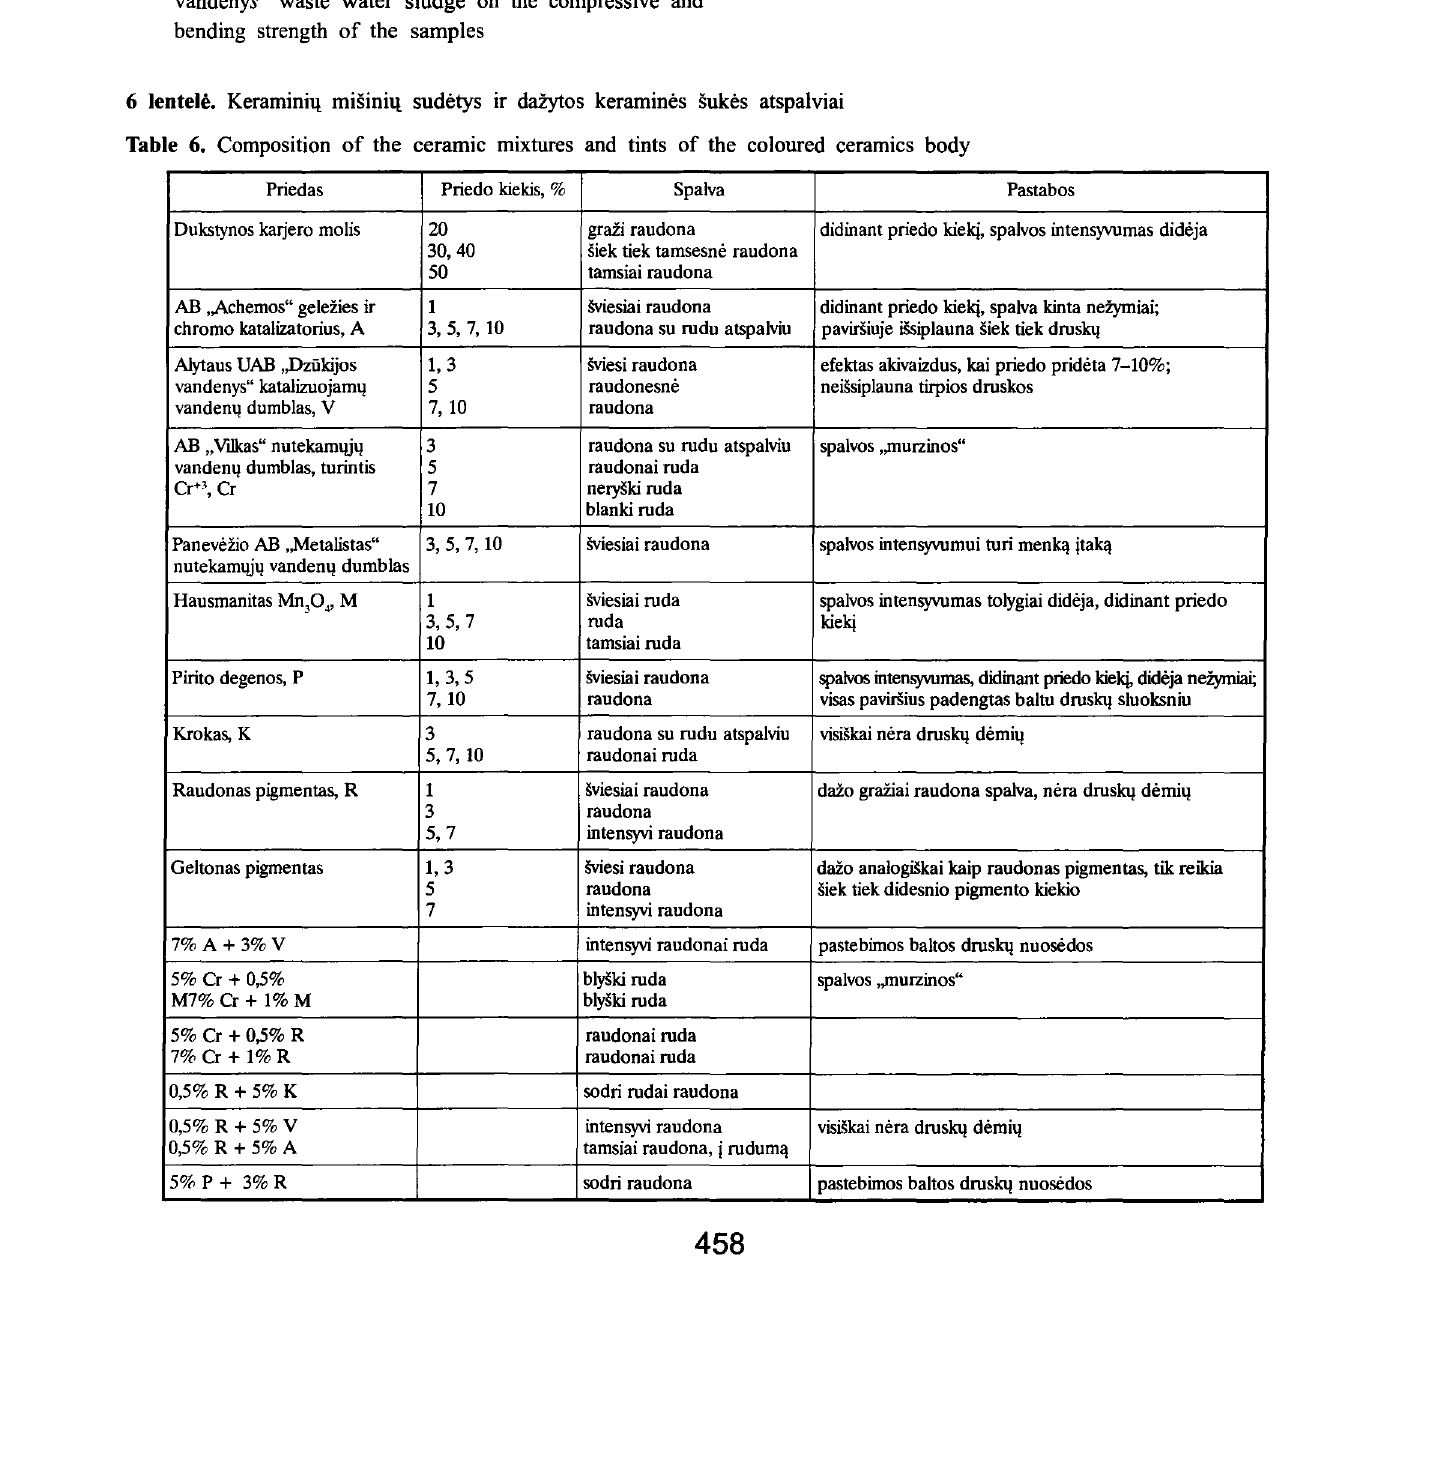
Fig 2. The influence of the amount of the JSC "Dziikijos vandenys" waste water sludge on the compressive and bending strength of the samples